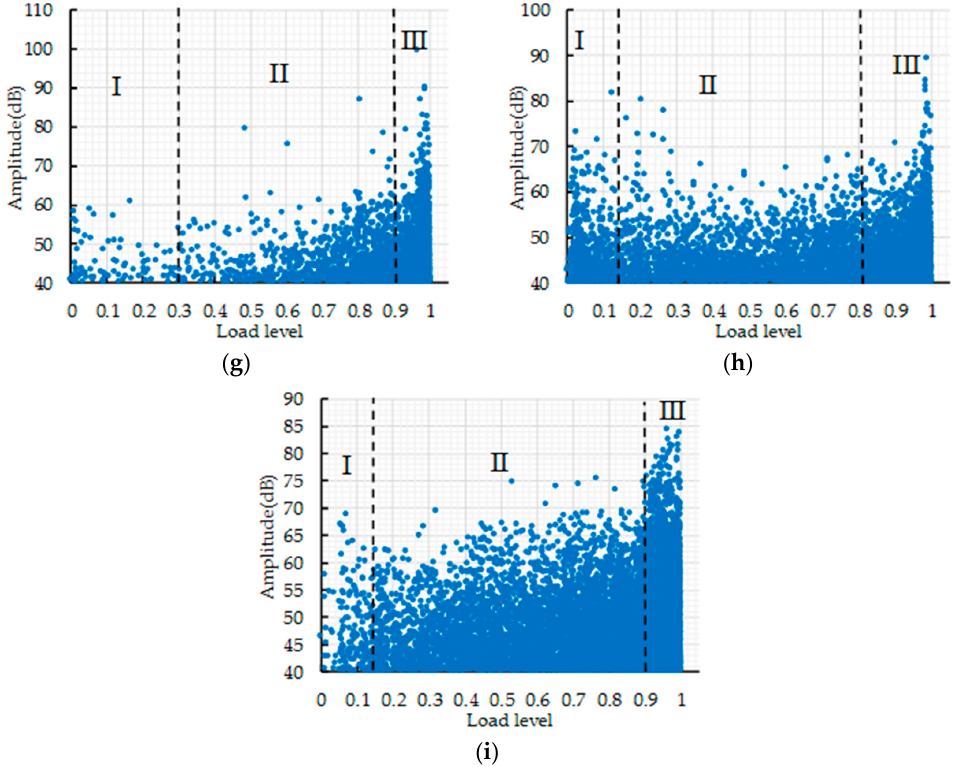
Figure 9. The distribution of AE amplitude values versus load level l: ( a ) A1; ( b ) A2; ( c ) A3; ( d ) A4; ( e ) A5; ( f ) A6; ( g ) A7; ( h ) A8; ( i ) A9.